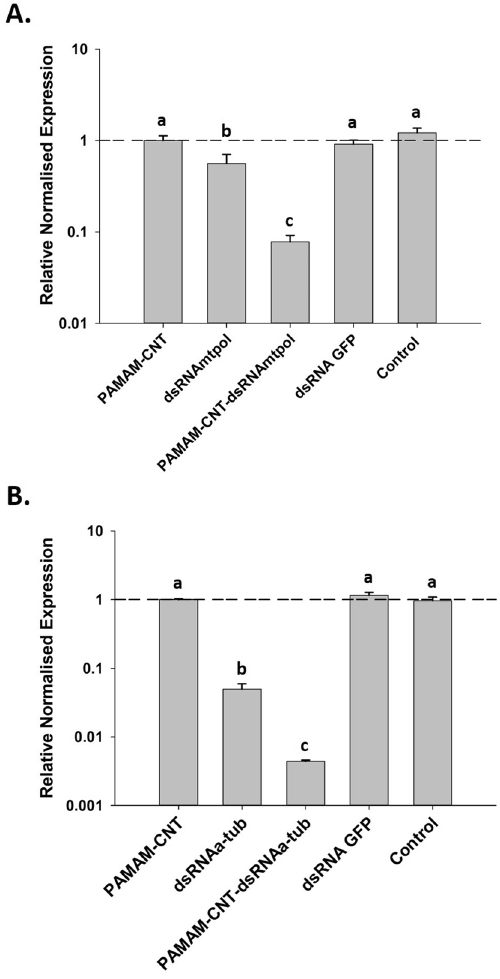
Figure 4. Relative normalised gene expression of targets after injection of PAMAM-CNTs, dsRNA or PAMAM- CNT-dsRNA complexes. mtpol expression ( A ) was significantly decreased following injection of naked dsRNA mtpol at 72 h ( P < 0.05) post-injection. mtpol expression was also significantly reduced in PAMAM-CNT-